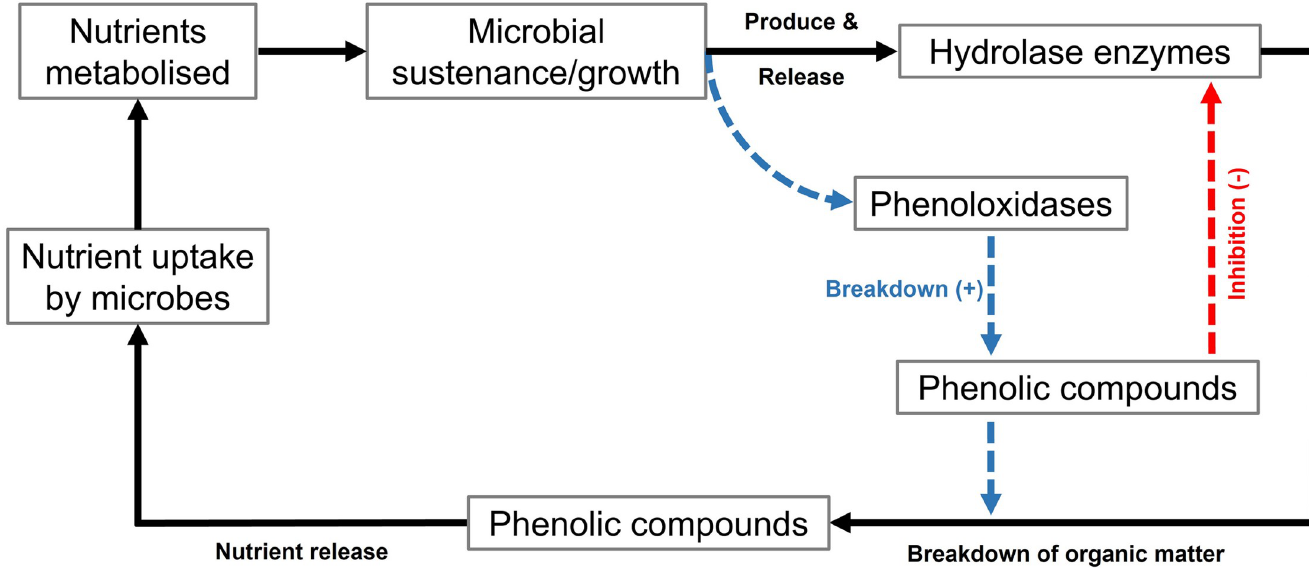
Fig 1. Schematic representation of the role of phenoloxidase enzyme(s) in nutrient cycling. The solid lines represent the normal/primary microbial nutrient cycle; the dotted line represents the secondary nutrient cycle. Plus (+) and minus (-) signs indicate positive (breakdown) and negative (inhibitory) effects on the system.